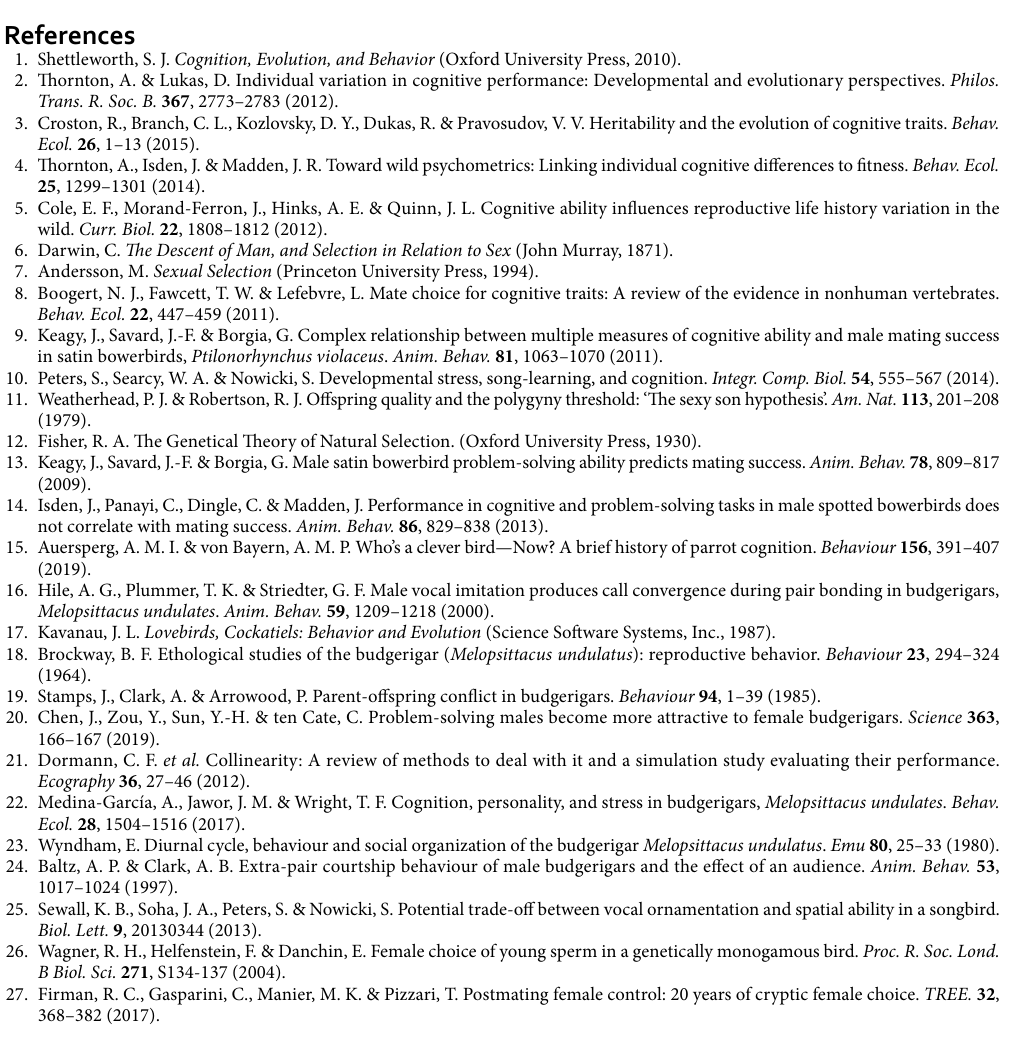
Figshare: https:// figsh are. com/s/ 82d56 c79c8 dd1cc